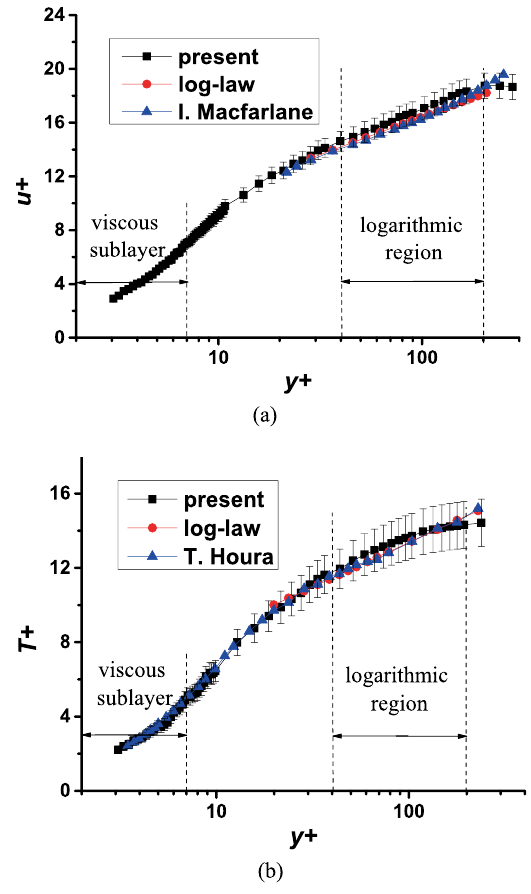
Figure 6. Verification of techniques. ( a ) Comparison of u + with I. Macfarlane 21 ; ( b ) Comparison of T + with T. Houra 17 .